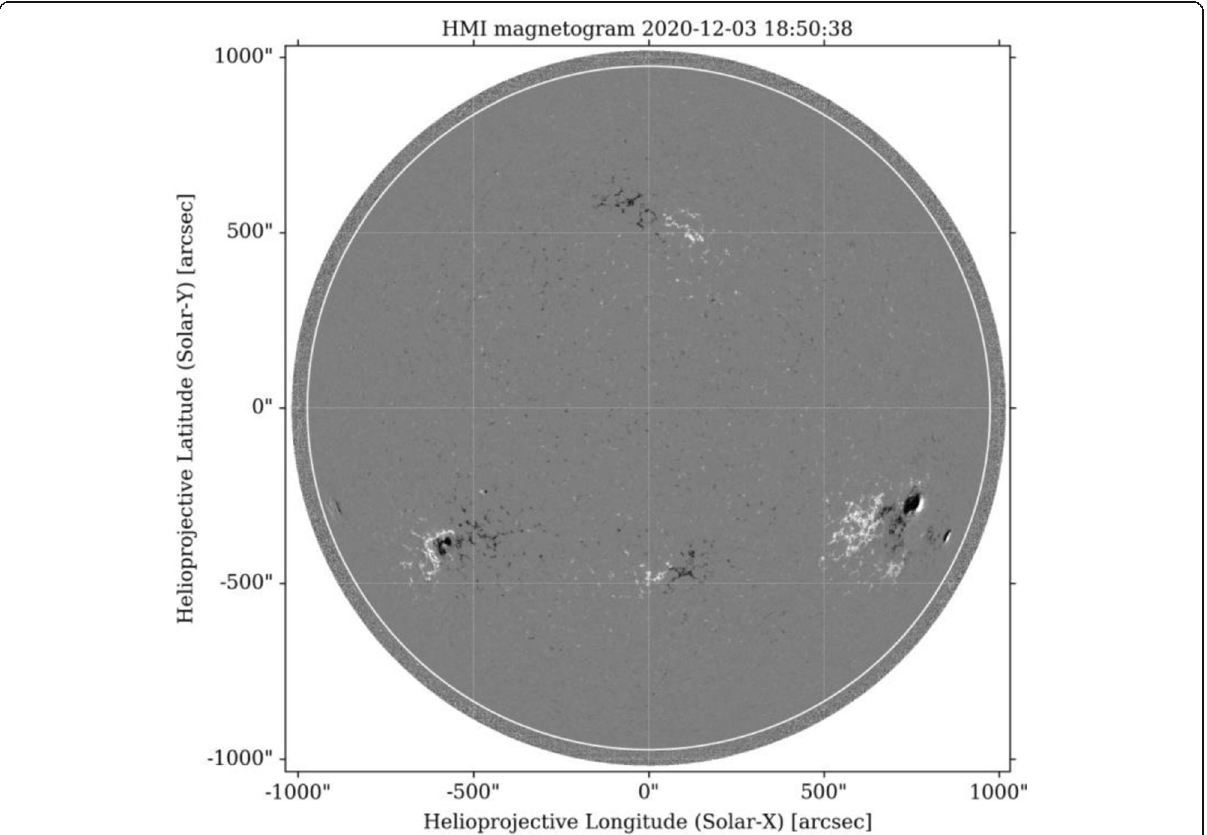
Fig. 1 A solar magnetogram shows regions of strong magnetic fields (solar active regions) on the solar surface which are typically composed of bipolar sunspot pairs (white and black regions indicate positive and negative polarity, respectively). These bipolar sunspots appear with a systematic tilt with respect to the local parallel of latitude and their relative orientation is reversed in the two hemispheres. The tilt angle that is observed within the solar active regions increases with latitude which is known as Joy ’ s law. Sunspots and associated overlying magnetic field loops generate solar storms and modulate the radiative energy output of the Sun. They are tracers of the underlying solar dynamo mechanism. Credit: NASA